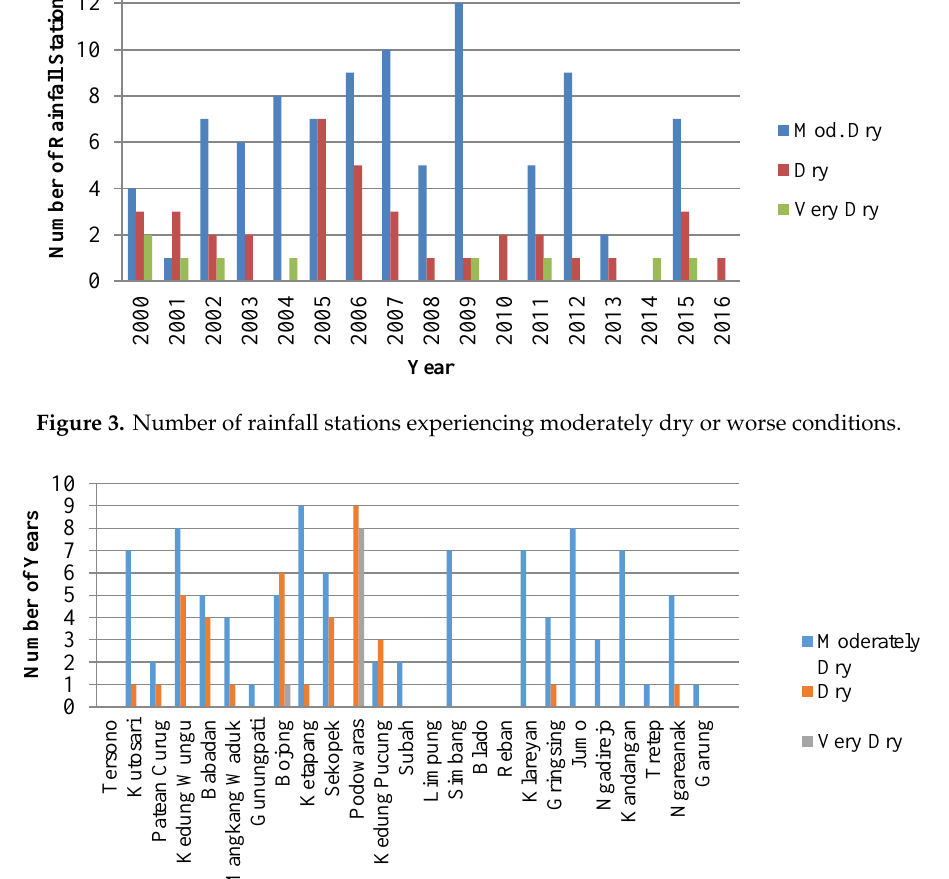
Figure 4. Rainfall stations experiencing moderately dry or worse conditions.